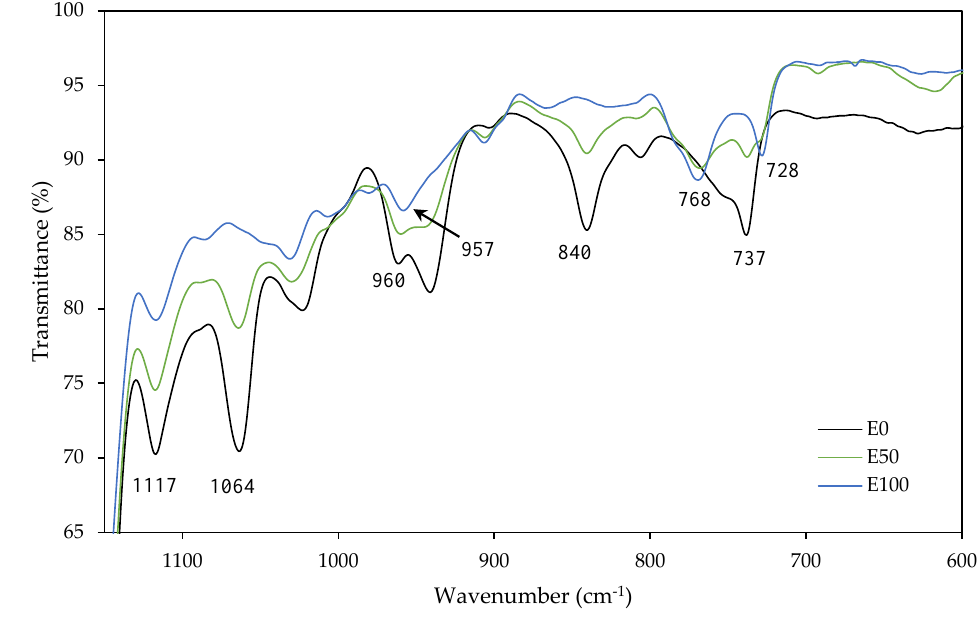
Figure 5. FTIR spectra of E0, E50 and E100 samples over a range of wavenumbers of 1150–600 cm − 1 .